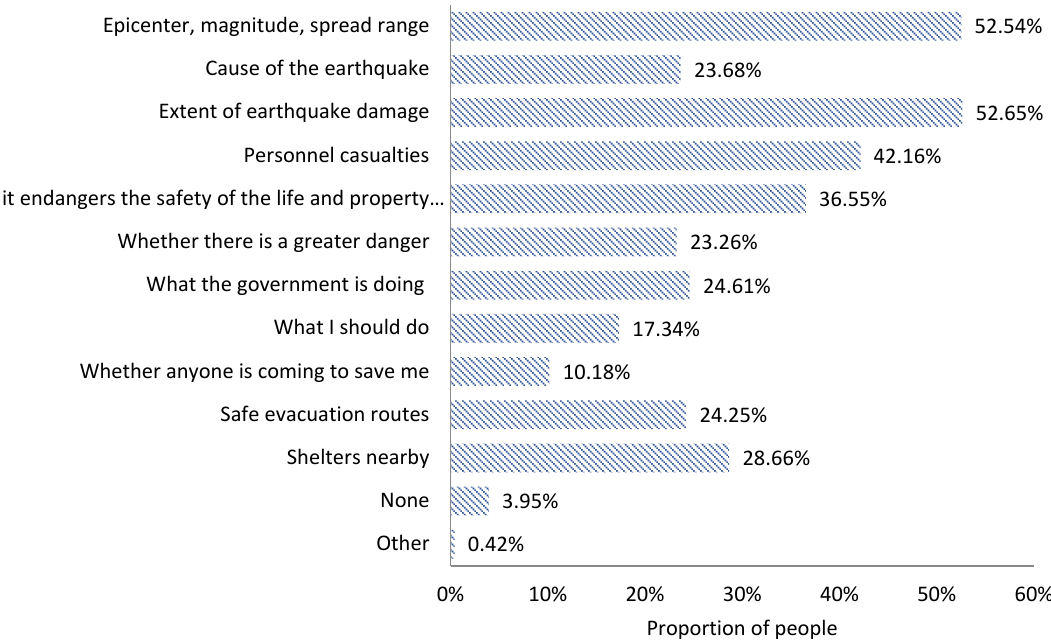
Figure 5. Information actually acquired by the public in the acute stage of an earthquake disaster.